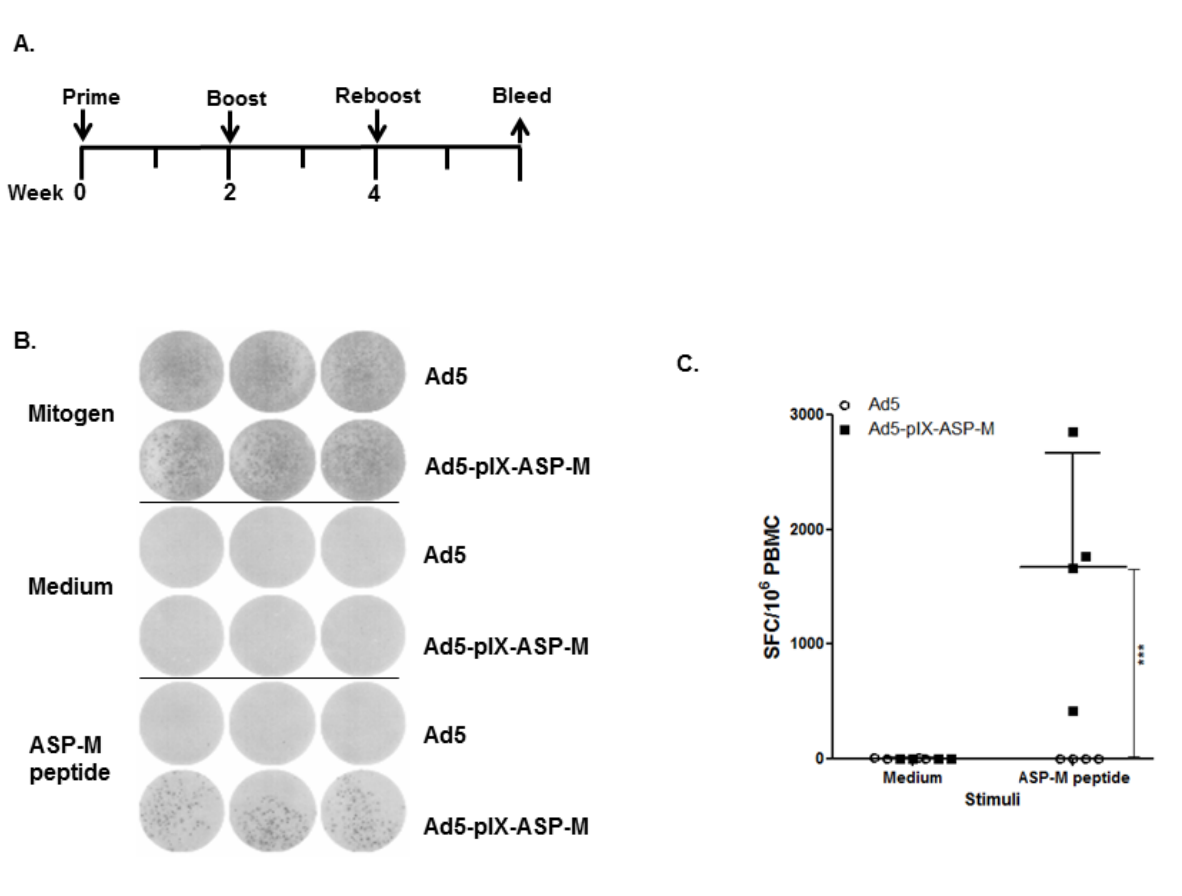
Figure 3. Immunization with Ad5-pIX-ASP-M induces IFN γ -secreting cells. (A): Animals were im- munized every 2 weeks for a total of 3 immunizations. PBMCs were obtained 2 weeks following the final immunization and were assayed by enzyme-linked immunosorbent spot (ELISPOT). (B): A representative ELISPOT. Well images of 4 × 10 5 PBMCs cultured with media, mitogen (PMA/ionomycin), or ASP-M pep- tides. (C): Analysis of ASP-M IFNγ-producing cells in PBMC upon immunization with Ad5-pIX-ASP-M. Each square or dot represents the mean number of IFN γ secreting cells per 10 6 PBMC for an individual mouse. (***) = P <